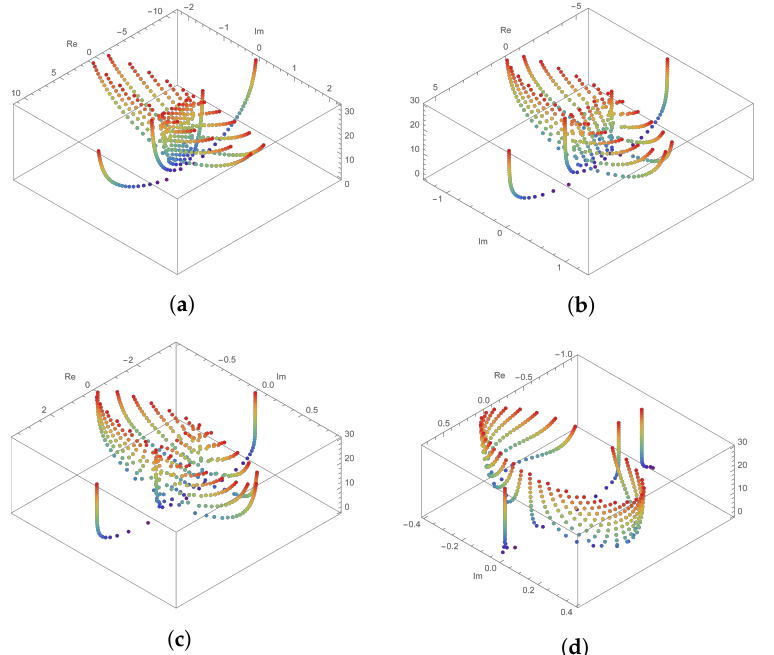
Figure 1. Structures of approximation roots of C S n ,0.9, q ( x ,2 ) for q = 0.8,0.7,0.6,0.1 with 0 ≤ n ≤ 30 . ( a ) C S n ,0.9,0.8 ( x ,2 ) ; ( b ) C S n ,0.9,0.7 ( x ,2 ) ; ( c ) C S n ,0.9,0.6 ( x ,2 ) ; ( d ) C S n ,0.9,0.1 ( x ,2 )